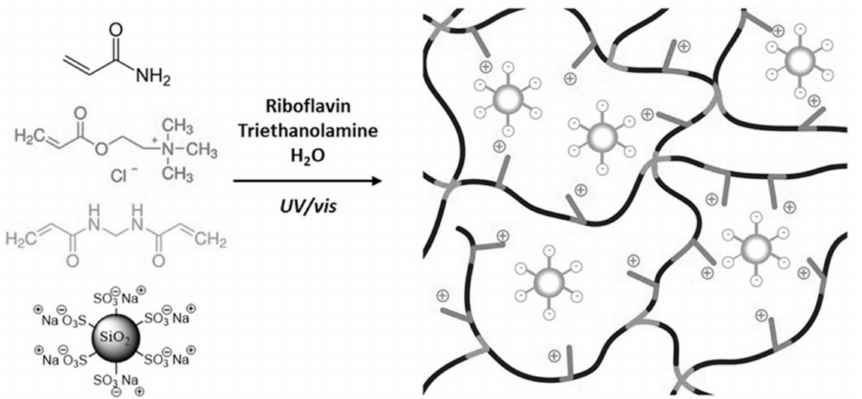
Figure5. Schematics presenting the formation of theionic composite hydrogels via photopolymerization with the presence of sulfonate modified SiO 2 nanoparticles [50]. Reprinted from [50] with permission from